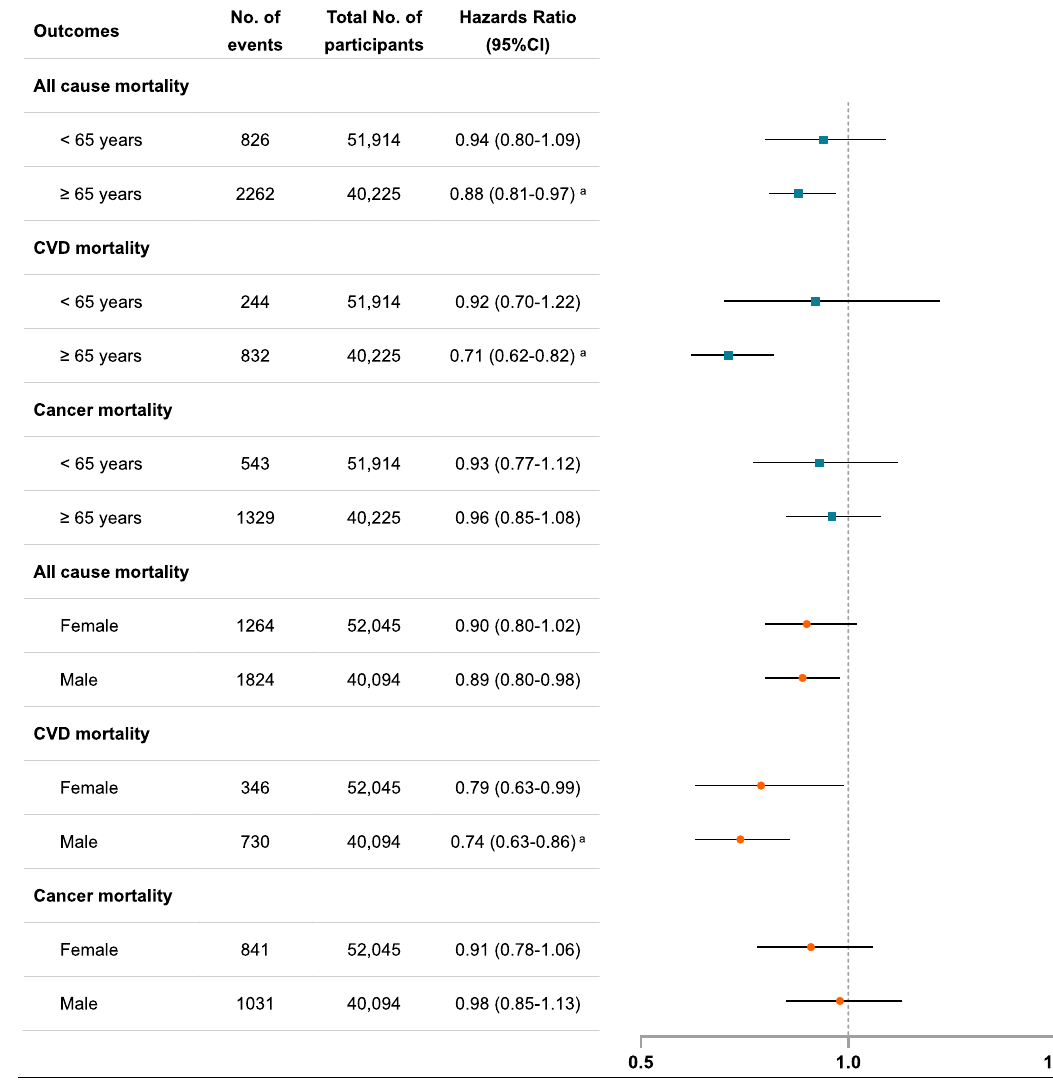
Fig. 2 | Subgroup analysis on the associations between favorable timing of MVPA (midday-afternoon & mixed vs. morning & evening) and mortality risk strati fi edby age and sex categories. a P values remained signi fi cant after multiple testing with the FDR method. Cox proportional hazard regression was used to examine the associations, which were adjusted for age, sex, ethnicity, Townsend deprivationindex,recruitmentcenter,educationlevel,theseasonofaccelerometer wear, smoking status, alcohol intake, healthy diet score, sleep duration (<7, 7 – 8, >8h), sleep midpoint, and total MVPA volume (Model 3). According to their